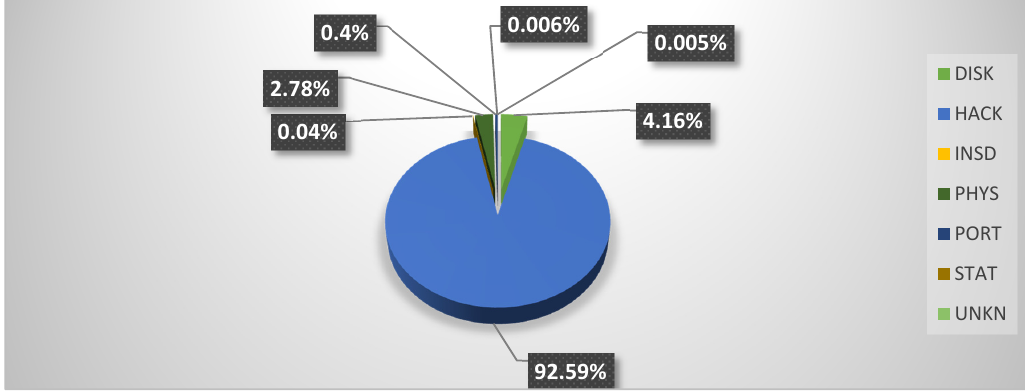
ff erent Types of